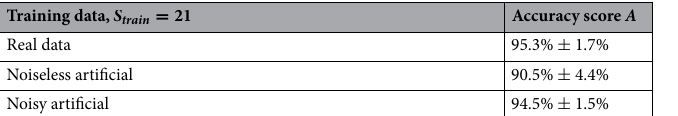
Training data, S train = 21